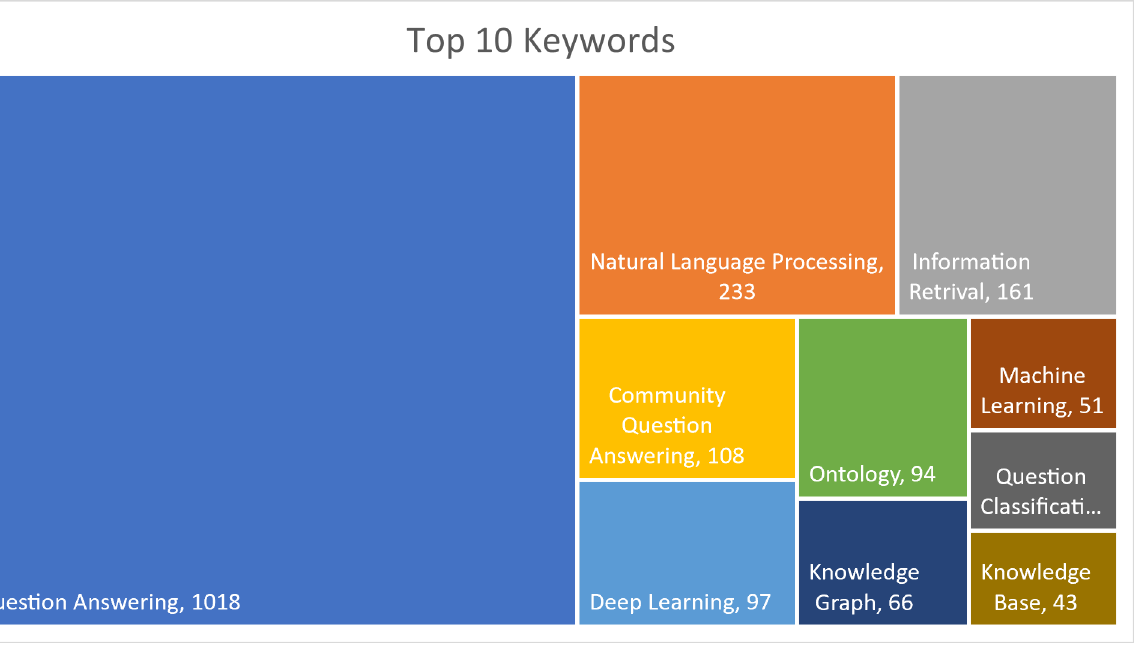
Figure 14. Top 10